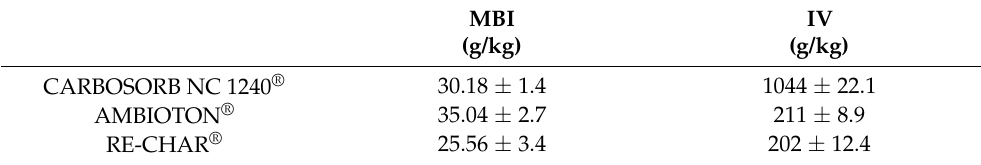
Table 11. Methylene blue index (MBI) and iodine index (IV) of carbonaceous materials